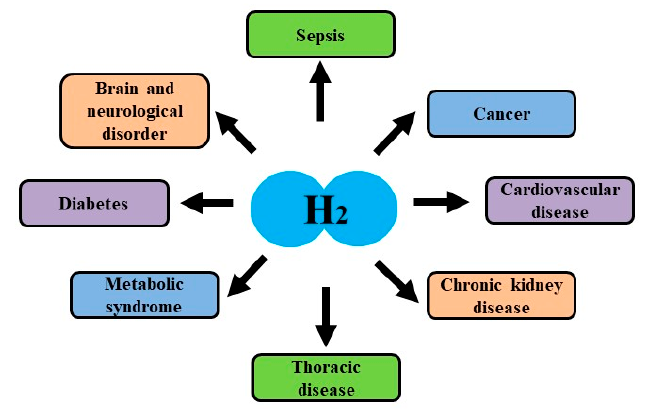
Figure 4. Therapeutic effects of hydrogen (H 2 ) on various diseases. The H 2 can treat many oxidative stress-related diseases without causing adverse effects.